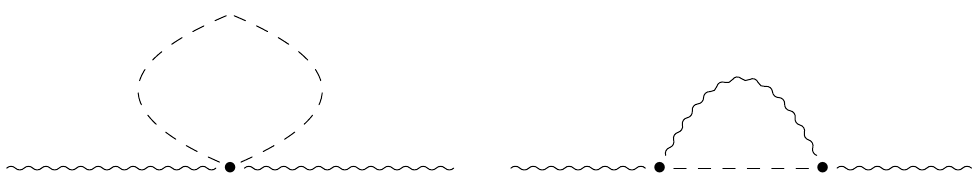
Figure 1 . One-loop corrections to the photon propagator arising from the scalar-vector couplings in the vectors’ kinetic terms. Wavy lines are photons, dashed ones